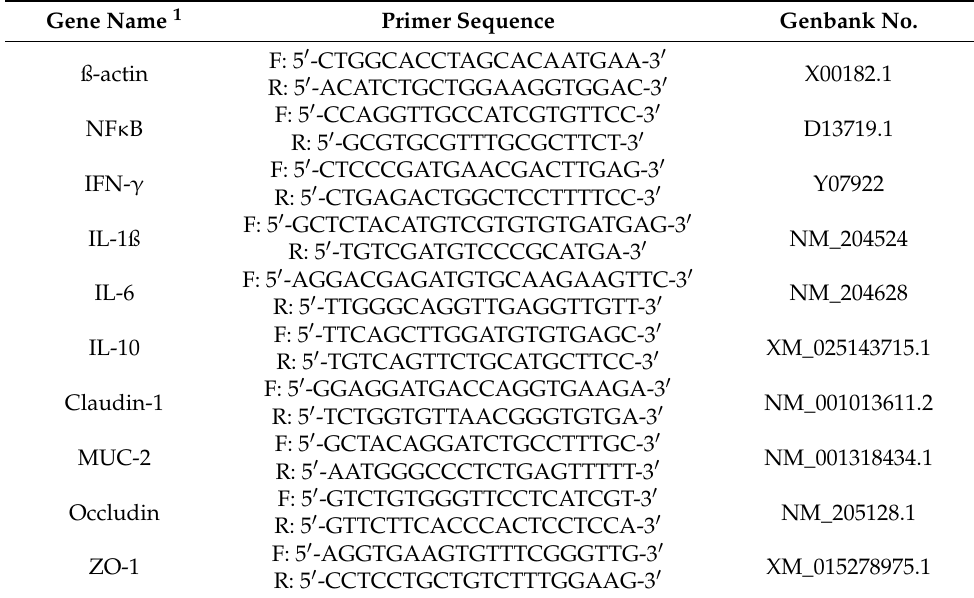
Table 3. The primer sequence of each gene according to Genbank or other